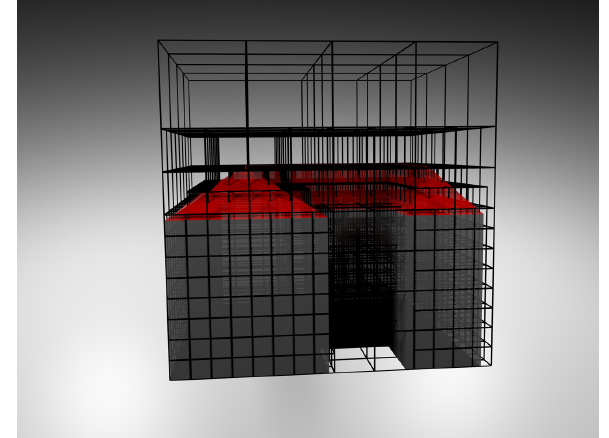
Figure 3: Majority decision of intersections to overcome topo- logical and geometrical errors. There is one missing wall sur- face in this example. The red ray has no intersection (it votes for the point being outside). The other 5 green rays have an un- even number of intersections (voting for inside). The probability P ( inside ) = 5 / 6 .